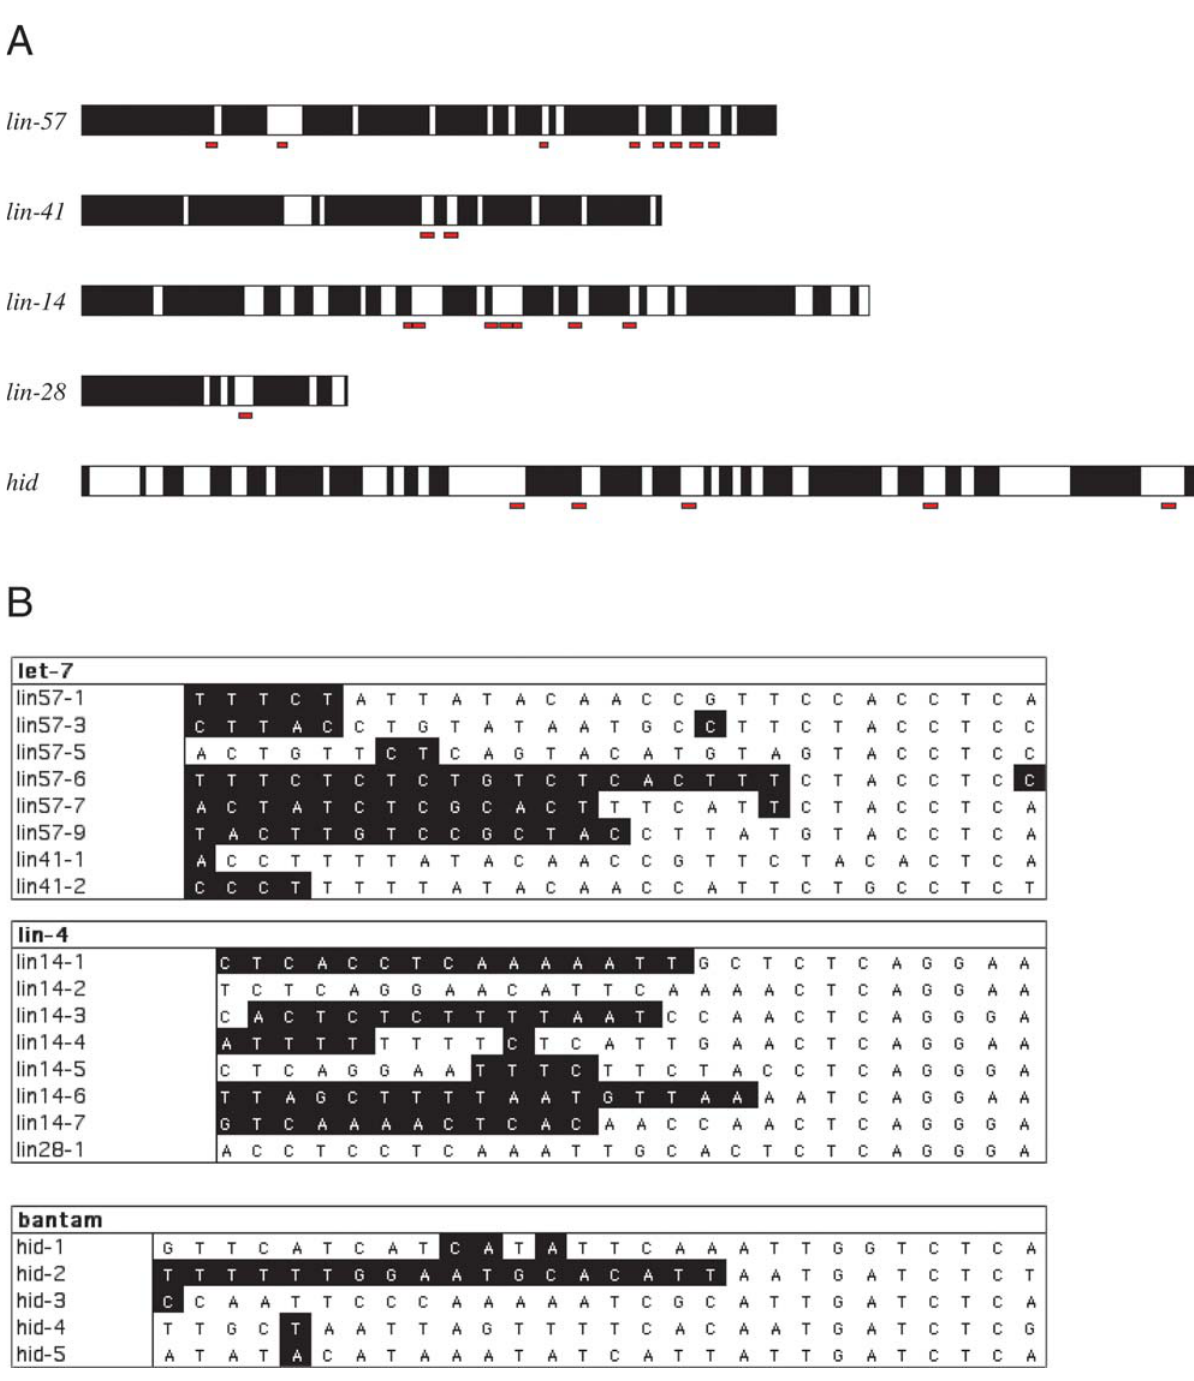
Figure 1. Features of Known miRNA Target Sequences (A) Comparison of sequence conservation in the 3 9 UTRs of miRNA target genes. For lin-14 , lin-28 , lin-41 , and lin-57 , comparison was between C. elegans and C. briggsae . For hid , comparison was between D. melanogaster and D. pseudoobscura . White regions indicate conservation, and black regions are not conserved under the conditions used for producing the 3 9 UTR database (see Materials and Methods for details). The positions of predicted miRNA target sites from the literature are shown in red. Most of these UTRs contain multiple predicted target sequences, and while regulation of the UTR has been experimentally validated in each case, most individual sites have not been tested for function. (B) Detailed comparison of the pattern of sequence conservation in the conserved sites. Target site length is miRNA length plus 5 nt. For lin-57 we excluded three of the eight previously predicted sites that were not located in conserved sequence blocks and included a newly identified ninth site that is conserved. White type on black indicates residues that are not identical in the target sites in the two genomes. Black type on white indicates identity. All residues basepairing with positions 2–8 of the miRNA are identical in the conserved sites in both genomes. DOI: 10.1371/journal.pbio.0000060.g001